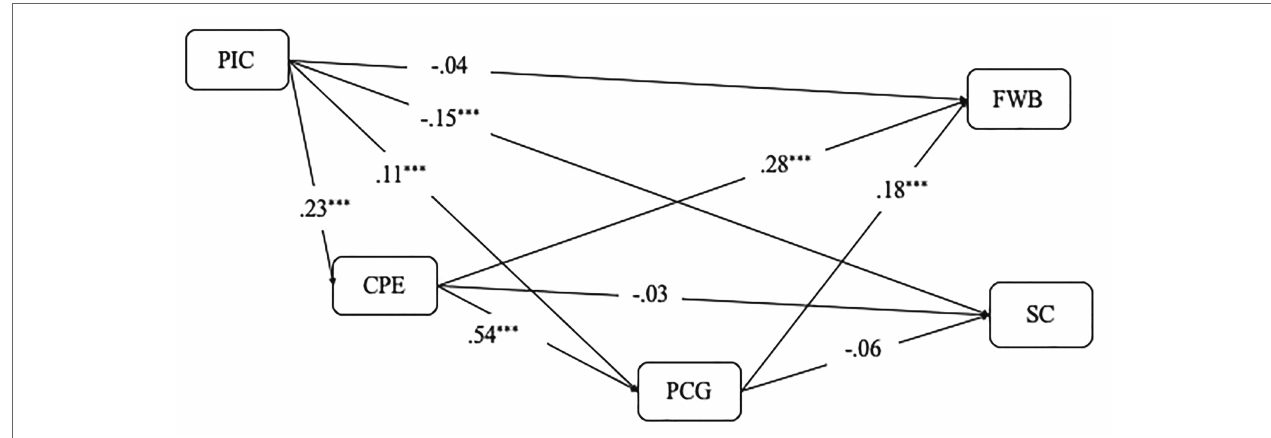
FIGURE 2 | Path estimates for the pooled sample of perceived impact of coronavirus disease 2019 (PIC COVID-19) on flourishing well-being (FWB) and SC mediated by creative process engagement (CPE) and perceived creative growth (PCG). *** p <